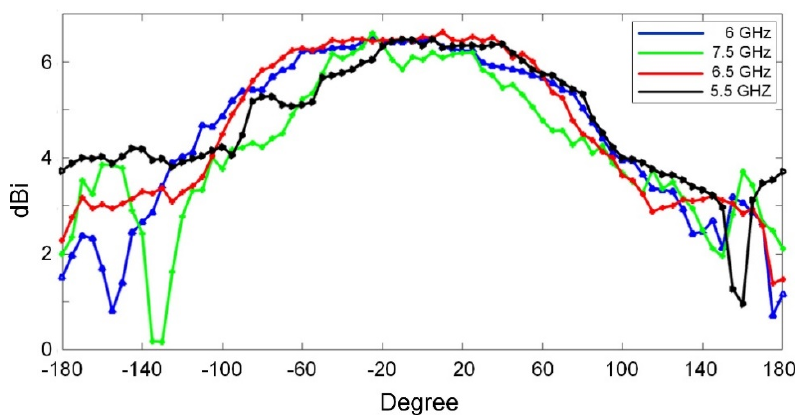
Figure 15. Gain plots at different frequencies.